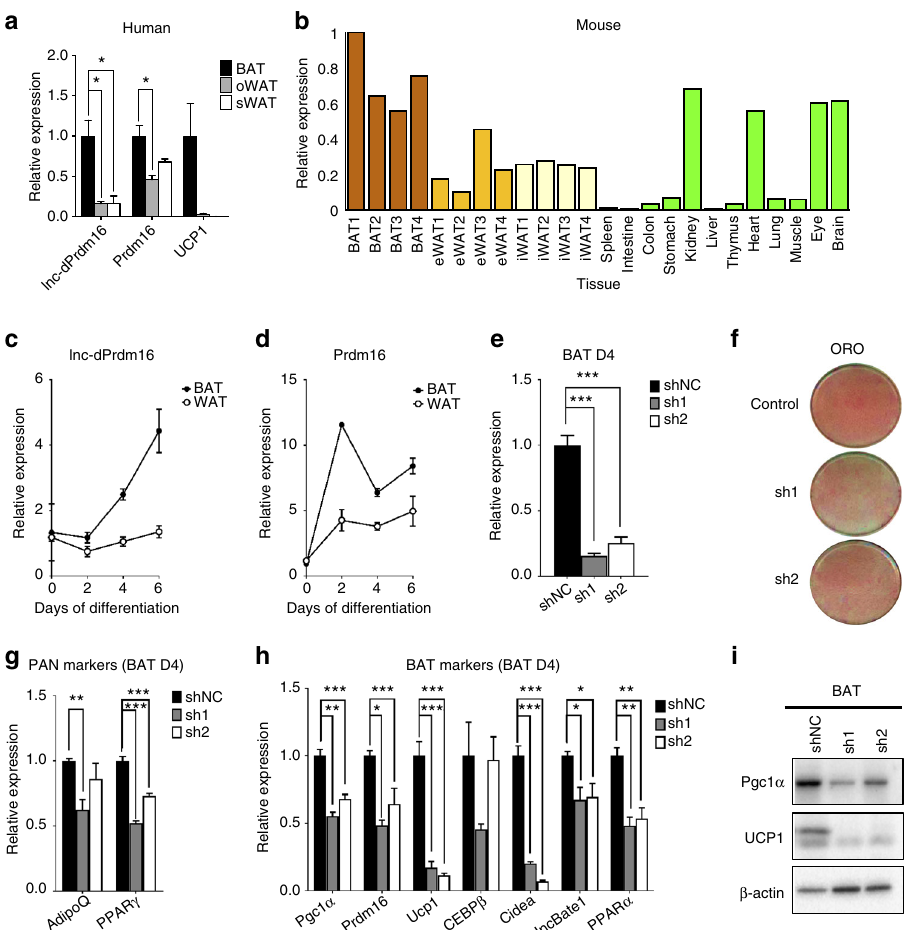
Fig. 8 The expression of lnc-dPrdm16 is needed for brown adipogenesis. a Real-time quantitative PCR analyses of lnc-dPrdm16 expression in human BAT, oWAT, and sWAT. Error bars represent mean ± SEM, n = 2/3. b Real-time quantitative PCR of lnc-dPrdm16 expression across 15 mouse tissues. c Real-time quantitative PCR analyses of lnc-dPrdm16 during mouse BAT and WAT adipogenesis. Error bars represent mean ± SEM, n = 4. d Real-time quantitative PCR analyses of Prdm16 during mouse BAT and WAT adipogenesis. e Knockdown ef fi ciency of lnc-dPrdm16 in cultured brown adipocytes, which were infected by retroviral shRNAs at precursor stages and then induced to differentiate for 4 days. Error bars represent mean ± SEM, n = 4. f Oil Red O staining at day 4 shows lnc-dPrdm16 knockdown reduces lipid accumulation, g lnc-dPrdm16 knockdown reduces PAN markers in BAT at day 4. Error bars represent mean ± SEM, n = 4. h lnc-dPrdm16 knockdown reduces BAT markers in BAT at day 4. Error bars represent mean ± SEM, n = 4. i Western blot to examine the protein levels of Pgc1 α and Ucp1 on cultured day 4 brown adipocytes, which were infected by retroviral shRNAs at precursor stage. * p ≤ 0.05, ** p ≤ 0.01, *** p ≤ 0.001 ( T